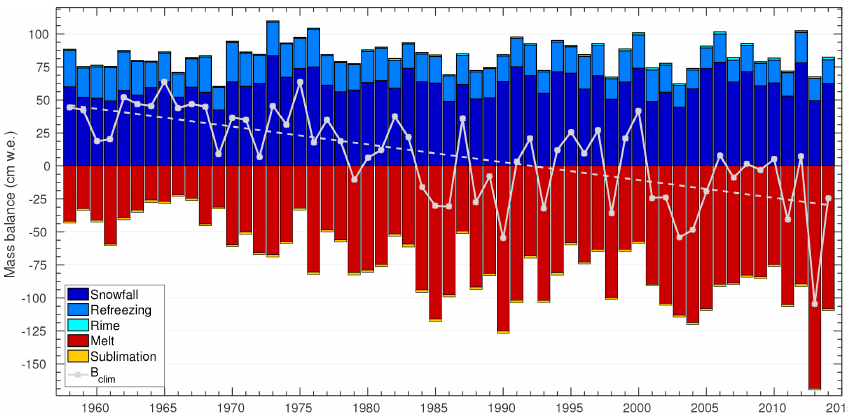
Figure 7. Annual specific climatic mass balance ( B clim ) and its components, 1957–2014. Area averaging is performed using the temporal glacier mask. Dashed line is the linear mass balance trend of − 14 ± 4 . 1cmw . e . yr − 1 decade − 1 , with uncertainty referring to 2 standard deviations. Table 5. Summary of modelled energy fluxes (Wm − 2 ) averaged over all glaciers and each year’s melt season (15 May–30 September) for the period 1957–2014. SD is 1 standard deviation of the temporal variability, R Q is the correlation with Q M over the melt season, β is the M estimate of a linear trend over 1957–2014, and σ slope is slope uncertainty given by 2 standard deviations. Slopes significant at the 95% level are marked in bold ( | β | > 2 σ slope